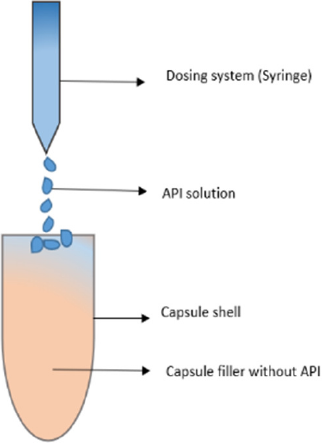
Figure 2. Schematic presentation of API dosing methodology.